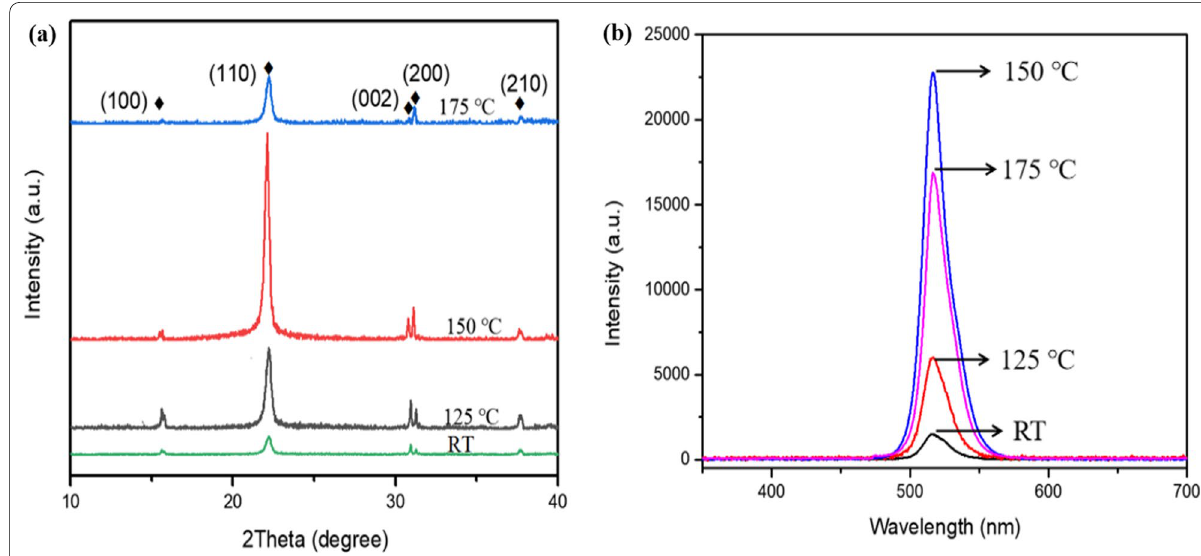
Fig. 3 a XRD patterns, b PL spectra of CsPbBr 3 films at different substrate